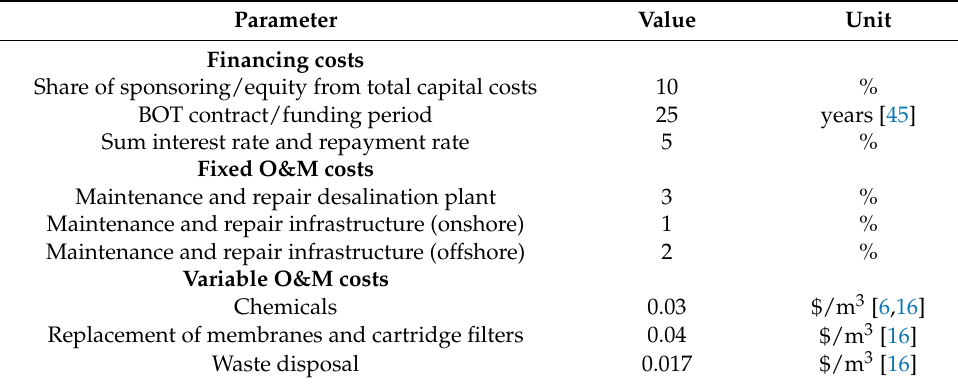
Table 3. Essential parameters for the economic